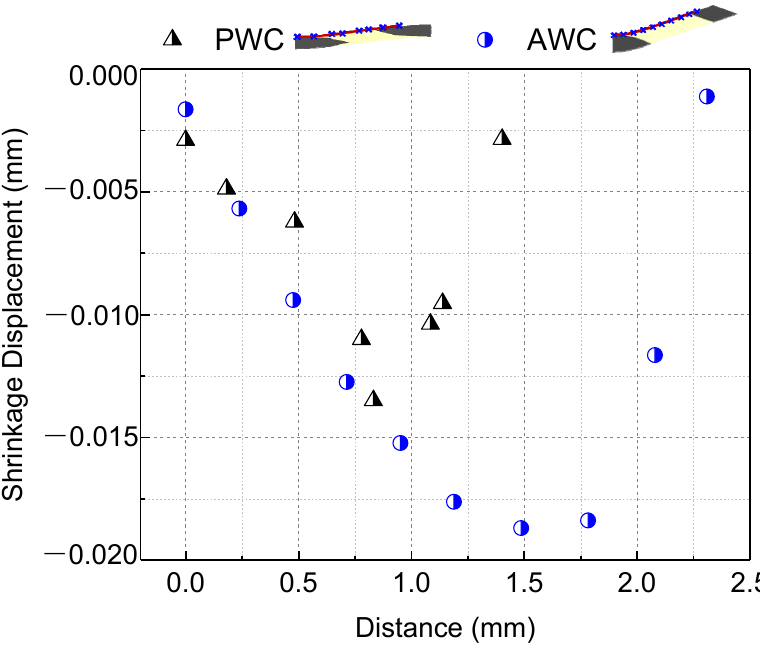
Figure 12. Comparison of shrinkage displacement with yarn distance in PWC and AWC.